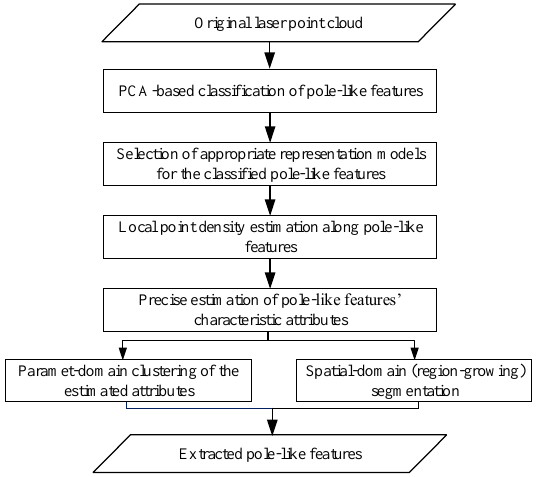
Figure 1.The outline of the proposed methodologies for the segmentation of pole-like features